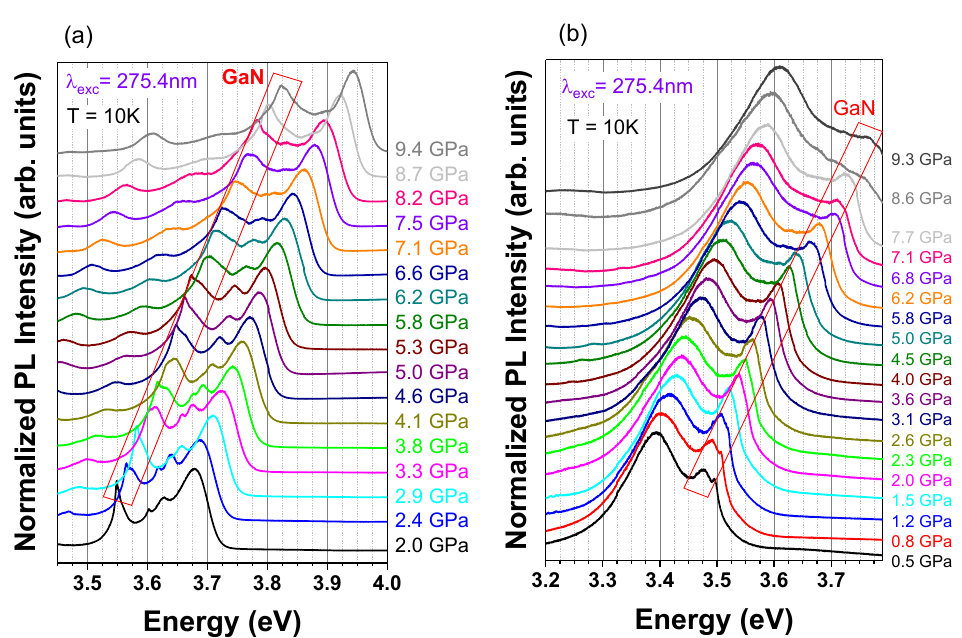
Figure 10. Pressure dependence of the low-temperature PL spectra of a non-polar ( a ) and polar ( b ) GaN/AlGaN MQWs. The emission from the GaN cap (marked by red tetragons) is visible in the whole range of pressures.